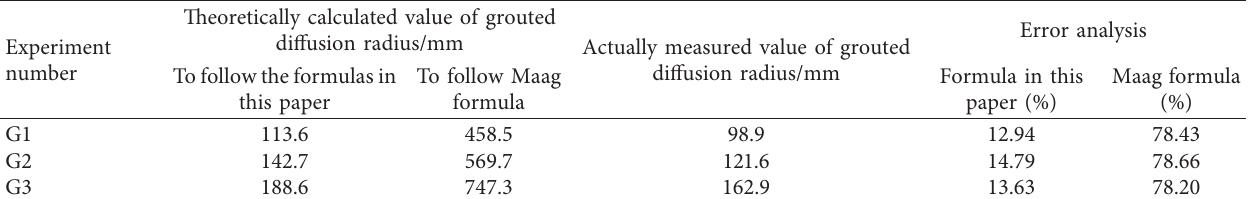
Table 5: The theoretical calculation and the actual measured values of the final diffusion radius in the grouting experiment. Theoretically calculated value of Experiment number